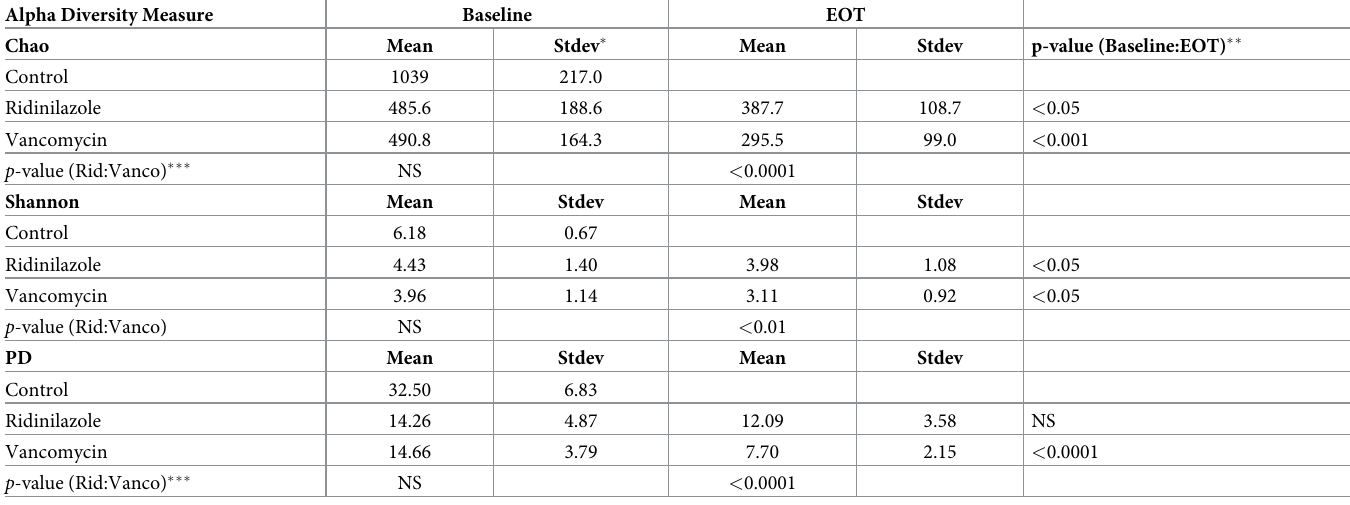
Table 2. Comparison of alpha diversity measures between baseline and end-of-treatment (EOT) within each treatment arm (horizontal), and between treatment arms (vertical). Alpha Diversity